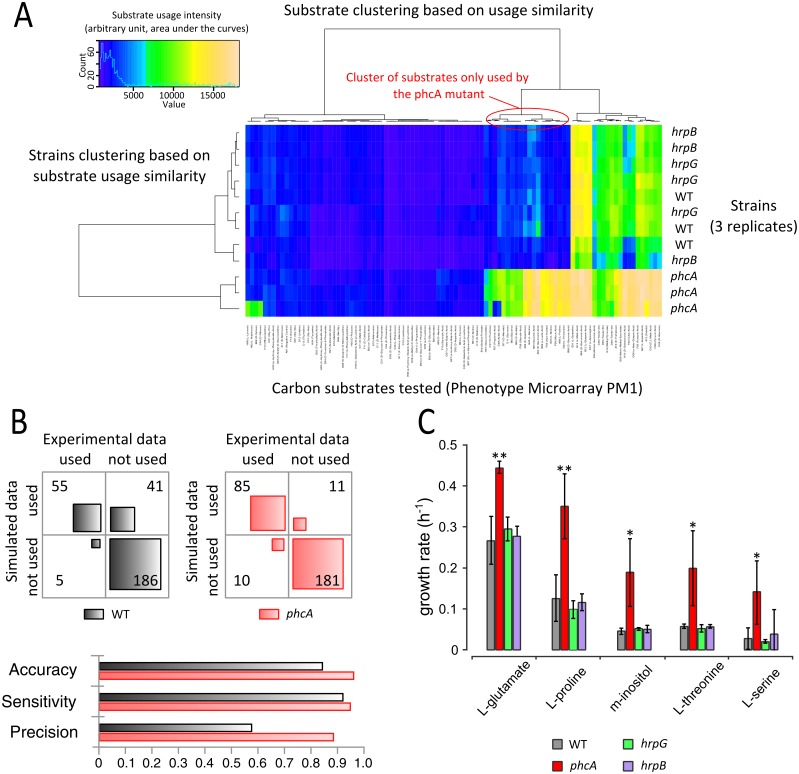
Virulence factor production restricts the versatility in a phcA-dependent manner.
(A) Heatmap of the phenotype microarray data (plate number 1, PM1) of strain GMI1000 (wild-type) and the regulatory mutants GMI1605 (phcA), GMI1755 (hrpG) and GMI1525 (hrpB). The clustering is performed depending on the similarity of substrates usages. (B) Maximum growth rate of the wild-type strain and the mutants in minimal medium supplemented with different carbon sources. Errors bars are 2*σ (95% data dispersion), n = 6, significance level (Student-test): *: p-value <0.05; **: p-value <0.01. (C) Contingency table of the simulated and experimental metabolic capacities of the wild type strain and the phcA mutant determined using phenotype microarray (PM1, 2, 3). The model performance is reported as precision, sensitivity and accuracy for the two data sets.